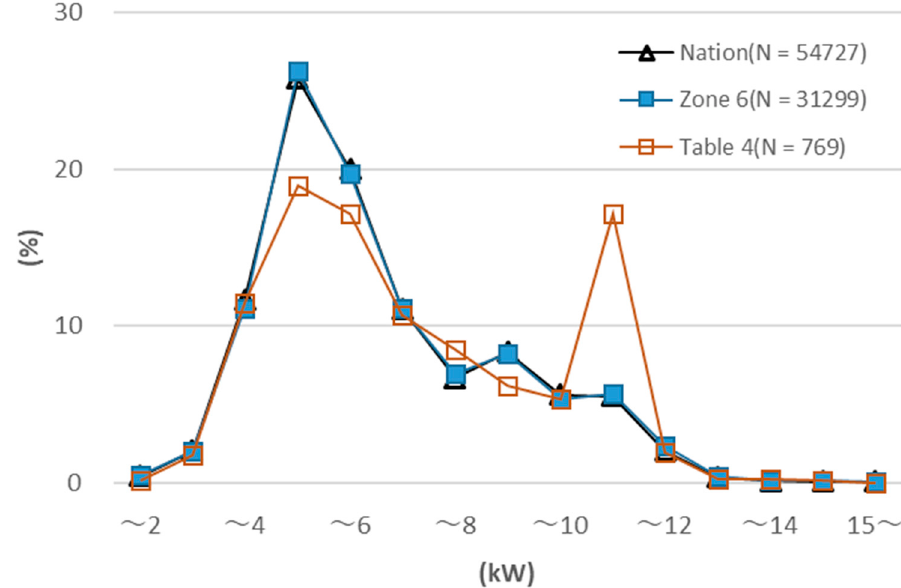
Figure 4. Capacity-based ratio of photovoltaic (PV) users.